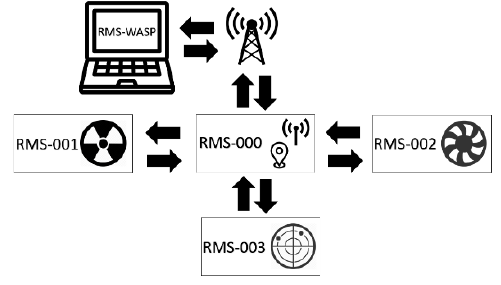
Fig. 1. 1. The schematic view of RMS modules.